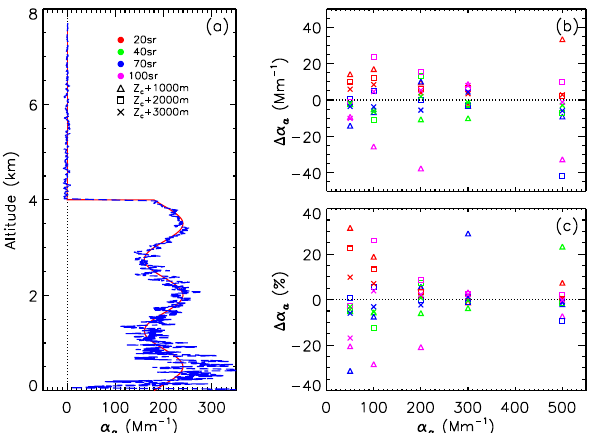
Fig. 6. Lidar signal simulation with the addition of shot noise. (a) Red solid line as in Fig. 4; dashed blue line: retrieved profile with reference taken between 275 and 725m (averaged reference to re- duce the influence of shot noise). (b, c) Difference 1α a , between the retrieved and the original profile at given fixed altitudes, in abso- lute and relative terms, respectively. Different colours indicate dif- ferent lidar ratios S 0 : red, 20sr; green, 40sr; blue, 70sr; and ma- genta, 100sr. Different symbols indicate different altitudes where 1α a is evaluated: triangles, Z c + 1km; squares, Z c + 2km; crosses, Z c + 3km ( Z c being the mean reference height). All evaluations of 21 1α a are averaged over a 100m deep layer centred at the indicated altitude, to reduce the influence of shot